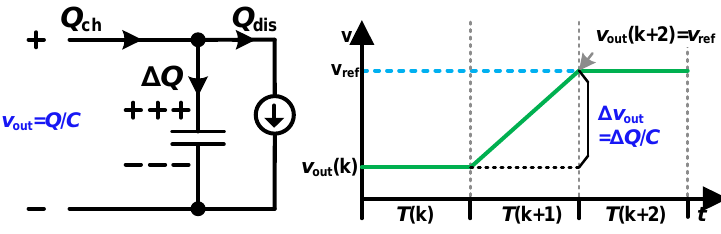
Figure 2. Output voltage under discrete charge balance (DCB) control.